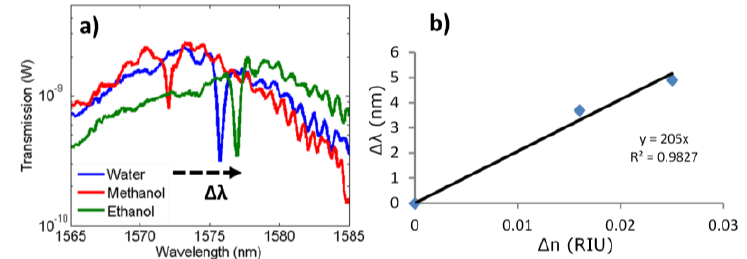
Figure 3. ( a ) Transmission spectra (log scale) for a single cavity immersed in a variety of solvents. ( b ) Resonance shift (Δn) versus refractive index change (Δλ) for measurements in